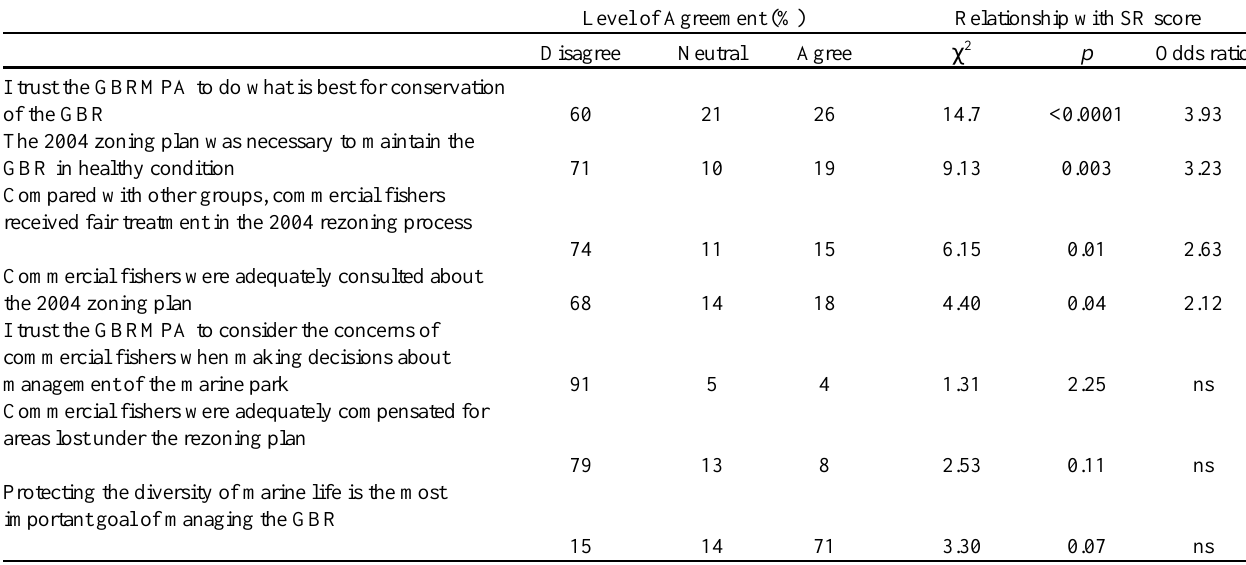
Table 3 . Queensland commercial fishers’ level of agreement with statements about management of the Great Barrier Reef, and results of proportional odds logistic regression models testing the relationship between each statement and social resilience (SR)